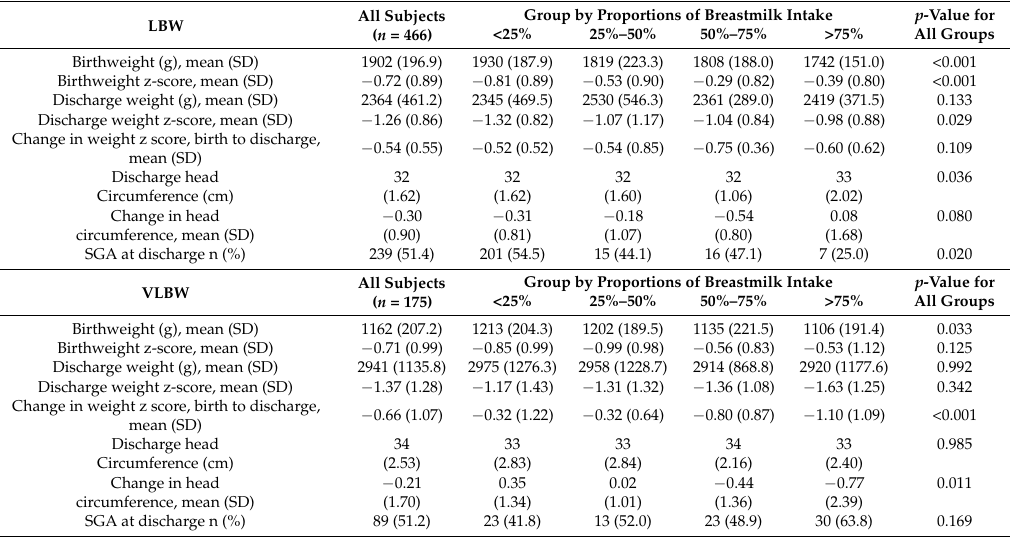
Table 4. Growth outcomes by proportion of breastmilk